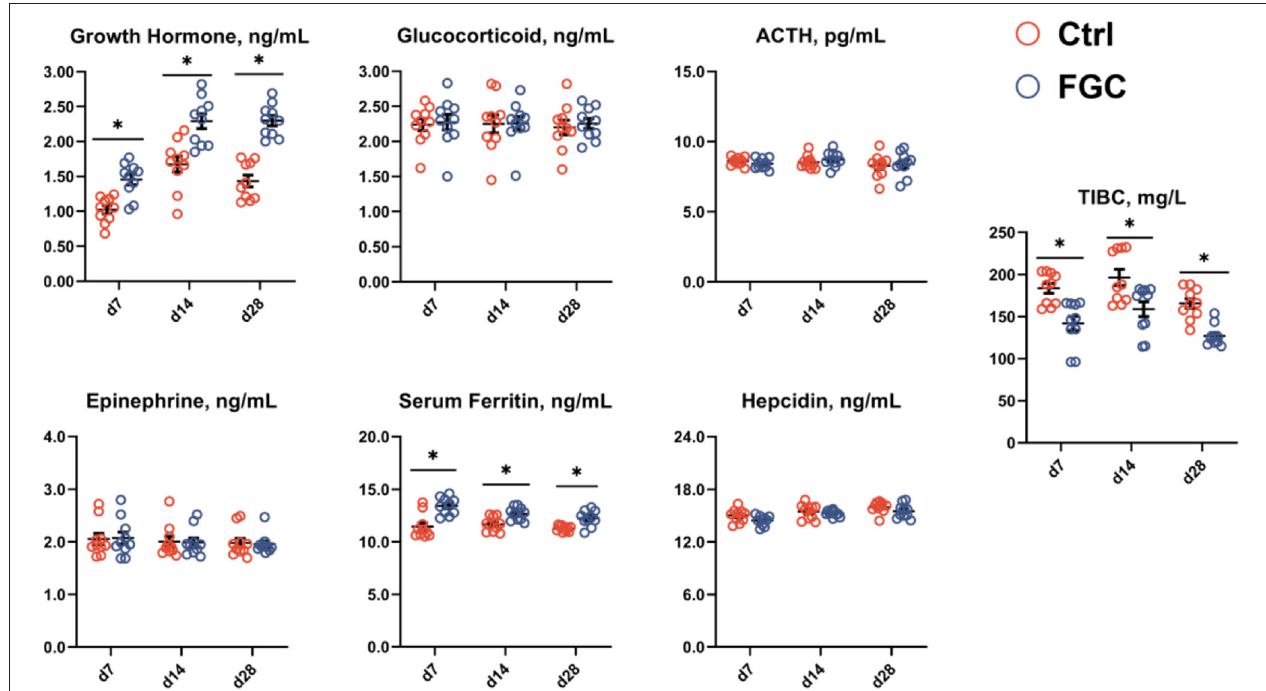
FIGURE 3 | Serum hormones and iron-binding capacity of 7d, 14d and 28d-piglets as affected by dietary ferrous glycine chelate supplementation. ACTH, adrenocorticotropic hormone; TIBC, total iron binding capacity. Ctrl, corn-soybean basal diet; FGC, corn-soybean basal diet with 2,000 mg/kg ferrous glycine chelate. Data were shown as means ± SEM. * p < 0.05. N =